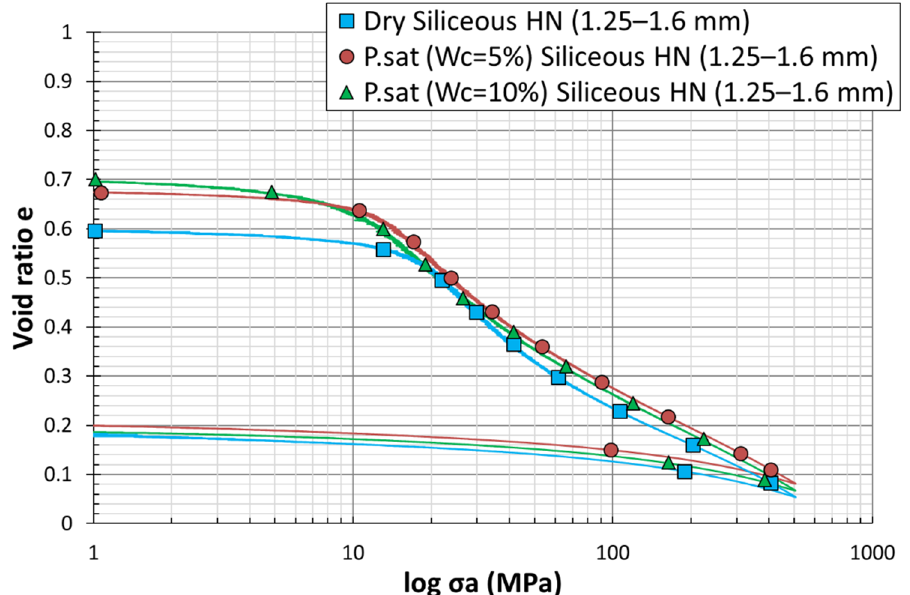
Figure 15. Load–settlement curves from dry and partially saturated oedometer tests on siliceous sand grains of 1.25–1.6 mm.